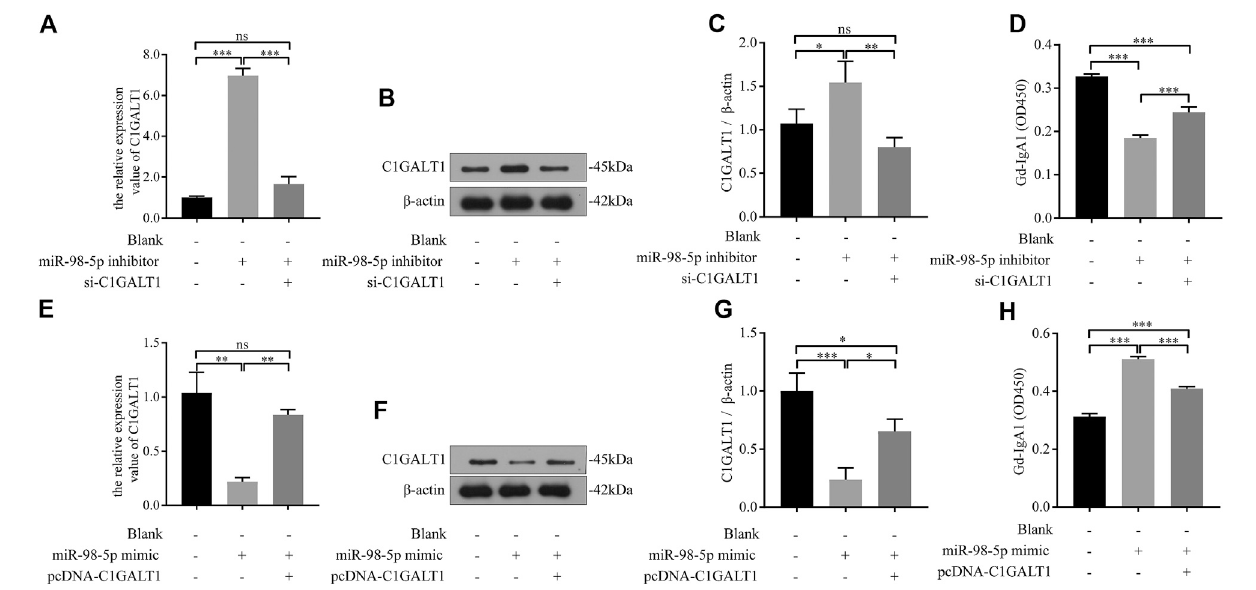
FIGURE5| miR-98 – 5pupregulatedthelevelsofGd-IgA1bytargetingC1GALT1inDAKIKIcells. (A,E) TheexpressionlevelsofC1GALT1mRNAwereanalyzedby qRT-PCR in DAKIKI cells. The relative expression level of C1GALT1 mRNA in the blank, miR-98-5p inhibitor and miR-98-5p inhibitor + si-C1GALT1 groups were 1.00 ± 0.05, 6.97 ± 0.29 and 1.66 ± 0.29. The relative expression level of C1GALT1 mRNA in the blank, miR-98-5p mimic and miR-98-5p mimic + pcDNA-C1GALT1 groups were 1.04 ± 0.15, 0.22 ± 0.03 and 0.84 ± 0.04. (B,F) The expression of C1GALT1 protein were analyzed by Western blotting in DAKIKI cells. (C,G) Fold changes were calculated by determining the ratios of the C1GALT1/ β -actin band intensities in DAKIKI cells. The semiquantitative relative level of C1GALT1 protein in the blank, miR-98-5p inhibitor and miR-98-5p inhibitor + si-C1GALT1 groups were 1.07 ± 0.13, 1.54 ± 0.20 and 0.80 ± 0.09. The semiquantitative relative level of C1GALT1 proteinintheblank,miR-98-5p mimicand miR-98-5p mimic+pcDNA-C1GALT1groupswere1.00 ± 0.13,0.24 ± 0.08and0.65 ± 0.09. (D,H) TherelativelevelsofGd- IgA1 were analyzed by VVA in the supernatant of DAKIKI cells. The relative levels of Gd-IgA1 in the blank, miR-98-5p inhibitor and miR-98-5p inhibitor + si-C1GALT1 groups were 0.33 ± 0.00, 0.19 ± 0.01 and 0.24 ± 0.01. The relative levels of Gd-IgA1 in the blank, miR-98-5p mimic and miR-98-5p mimic + pcDNA-C1GALT1 groups were 0.31 ± 0.01, 0.51 ± 0.01 and 0.41 ± 0.01. ns, no signi fi cance; * p < 0.05, ** p < 0.01, *** p < 0.001. Note: Gd-IgA1, galactose-de fi cient IgA1; C1GALT1, β -1,